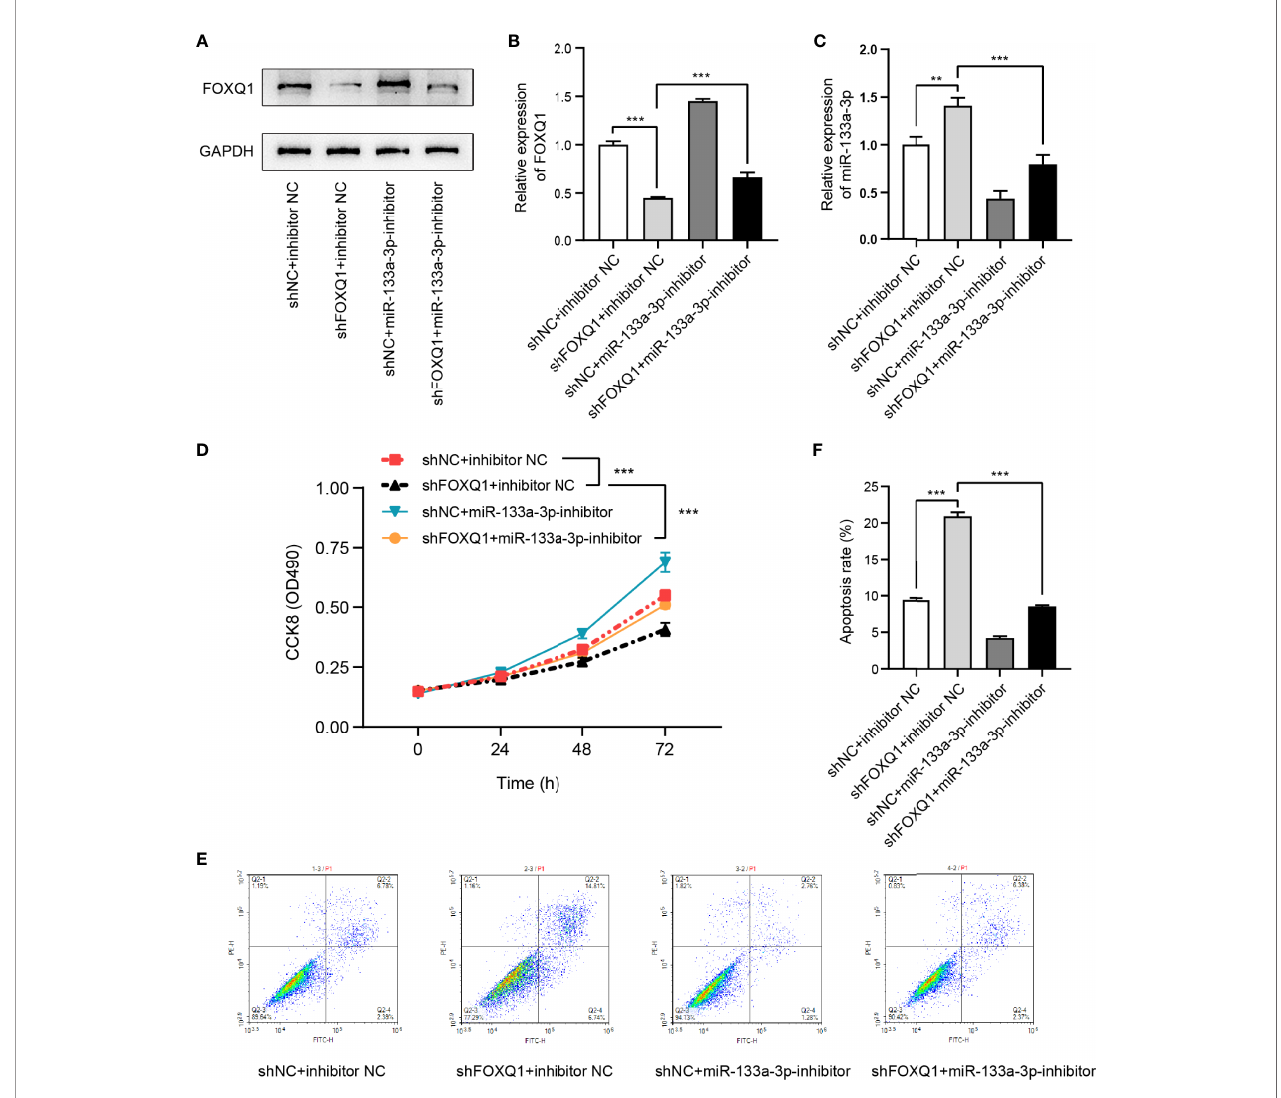
FIGURE 7 | FOXQ1 affects colorectal cancer (CRC) cell viability via miR-133a-3p. (A – C) . Expression of FOXQ1 (A, B) and miR-133a-3p (C) in miR-133a-3p inhibitor-, shFOXQ1-, or nonsense control (NC)-transfected CRC cells. (D) Cell proliferation was measured using the CCK-8 assay. (E, F) . Apoptosis following cell transfection was analyzed through fl ow cytometry (E) . Histograms showing the average numbers of apoptotic cells (F) (** p < 0.01, *** p <